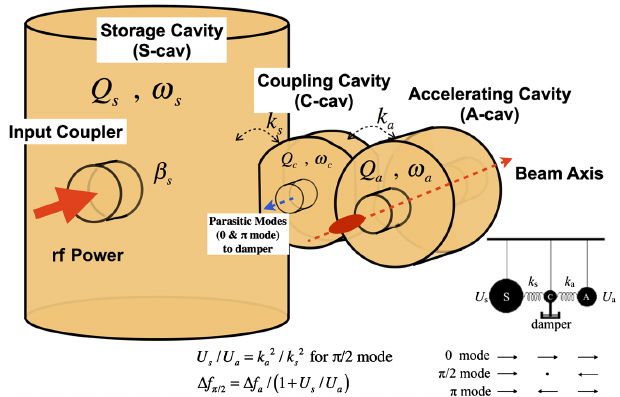
FIG. 1. Illustration of the ARES cavity structure (Ref. [9]). The accelerating (A-)cavity is coupled to the storage (S-)cavity via a coupling (C-)cavity. The C-cavity has a parasitic-mode (0 and π -mode) damper. An illustration of the coupled pendulum model is also